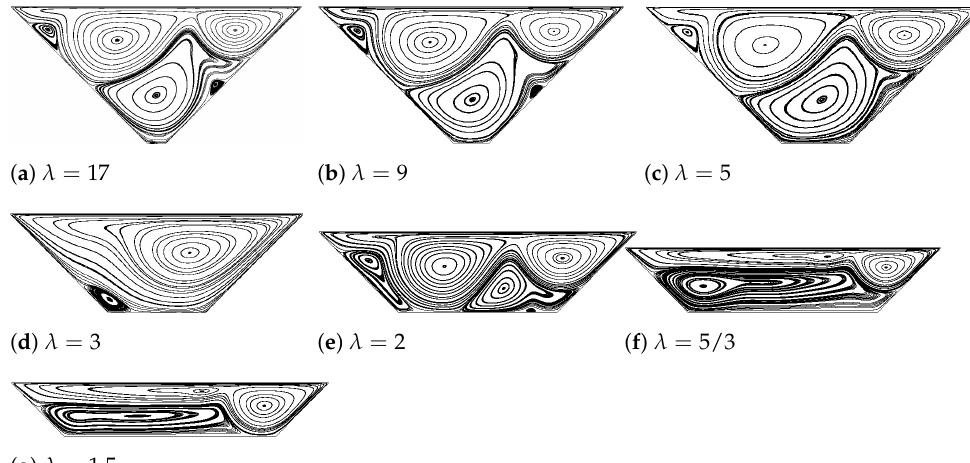
Figure 8. Streamlines inside the bowl-shaped trapezoid with various values of λ at Re =